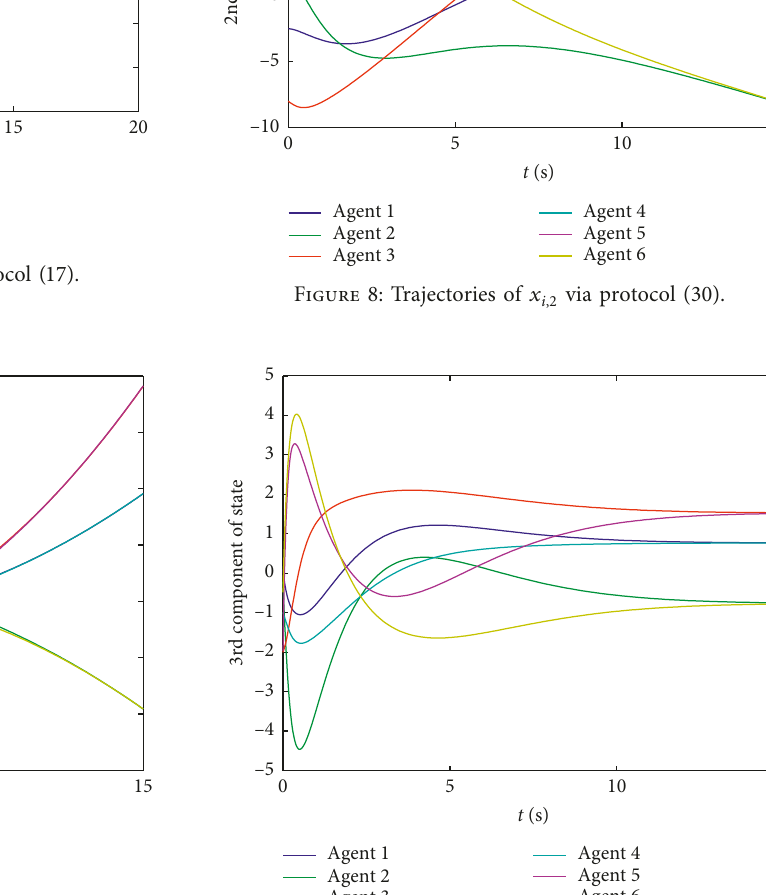
i, 1 via protocol (30).